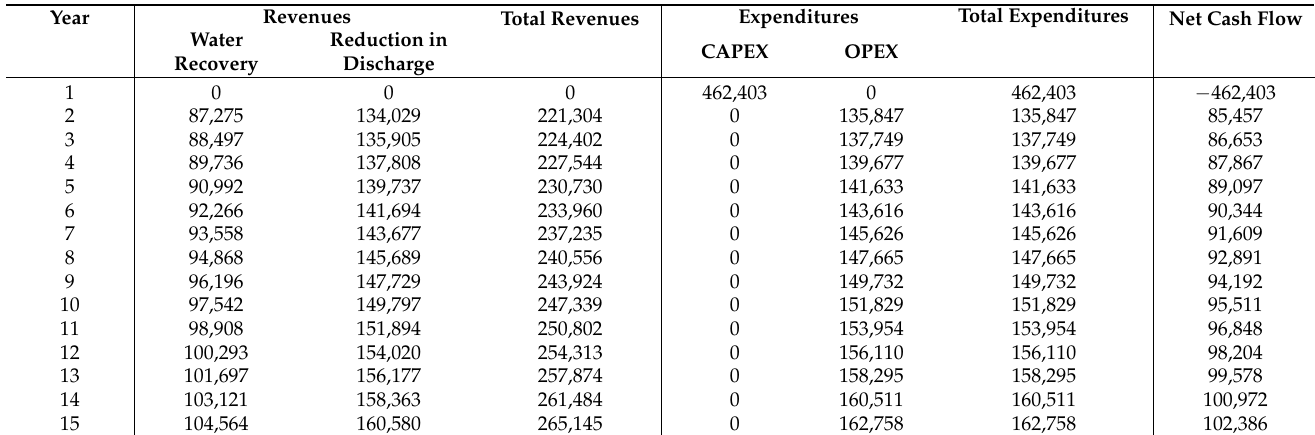
Table 8. Cash flow ( € ) assessment for membrane filtration